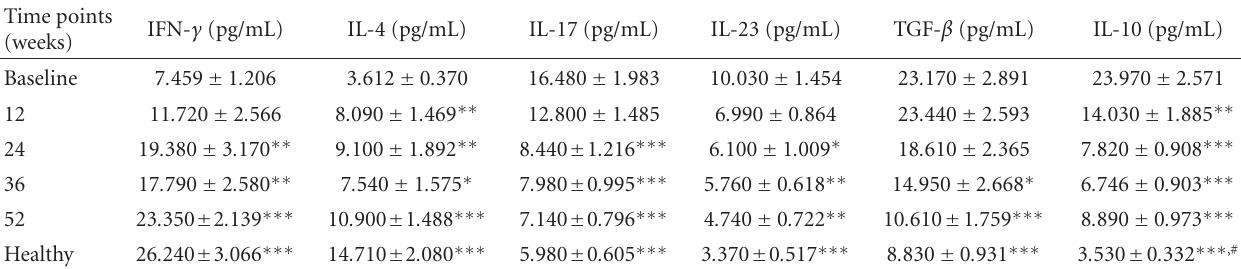
Table 2: Telbivudine treatment influence on CD4 + T-cell subtype-specific cytokines expressions in PBMCs from HBV patients.